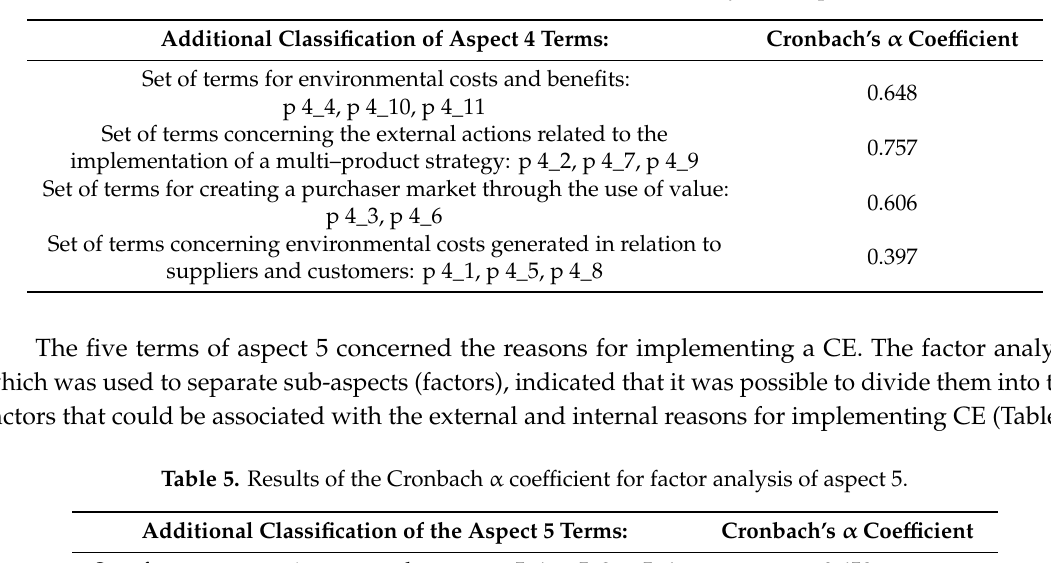
Table 4. Cronbach’s α coe ffi cient results for factor analysis of aspect 4.